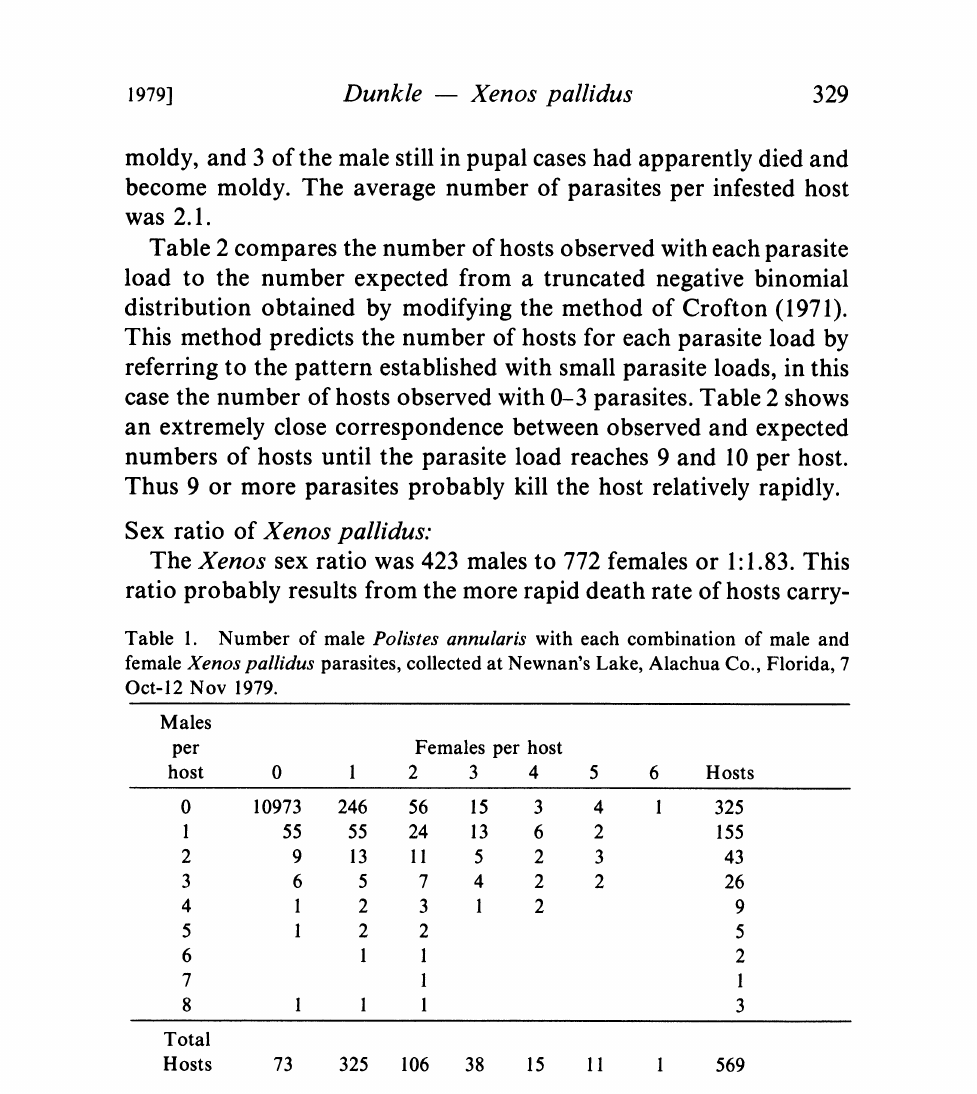
Table 2. Number of male Polistes annularis observed with 0 to 10 Xenos pallidus parasites compared with the number expected from a truncated negative binomial distribution, truncated at 3 parasites per